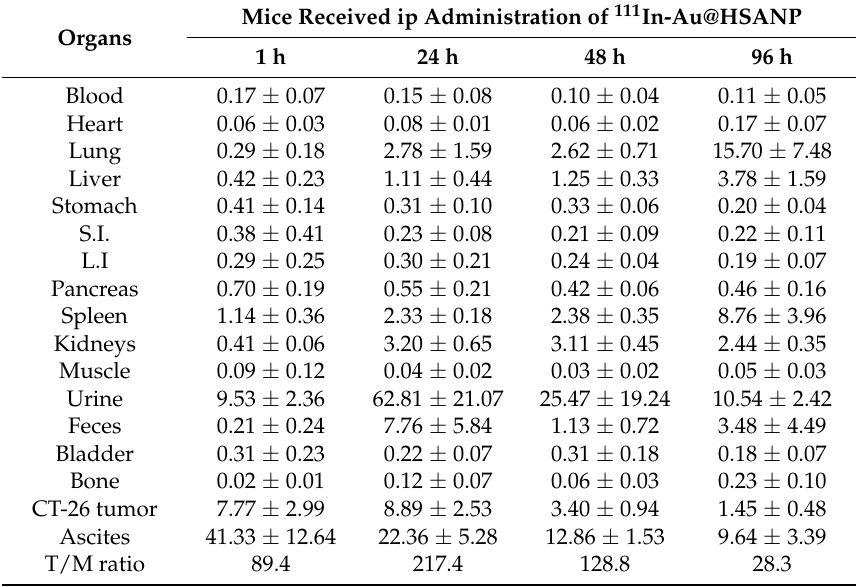
Table 4. Radioactivity distribution of 111 In-Au@HSANP in CT-26 tumor/ascites mice at one, 24, 48, and 96 h post intraperitoneal